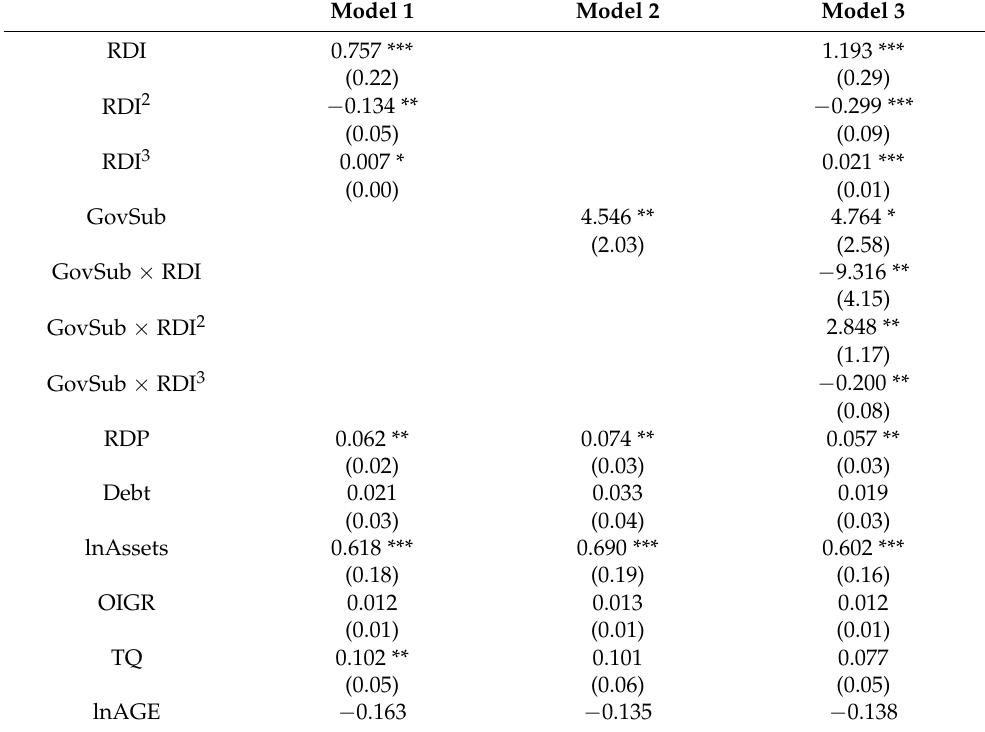
Table 4. Regression analysis results for the effects of R&D investment and government subsidies on technological